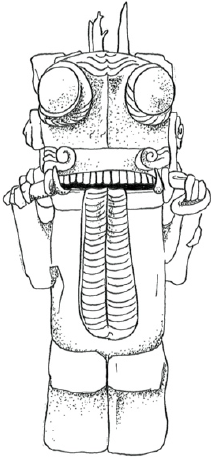
Figure 10. Line drawing of lacquered wood antlered kneeling sculpture from Tomb 1 at Changtai- guan, Xinyang, Henan. Adapted from Henan sheng wenwu yanjiusuo (1986, pl. 58) courtesy of Zay Olsen.